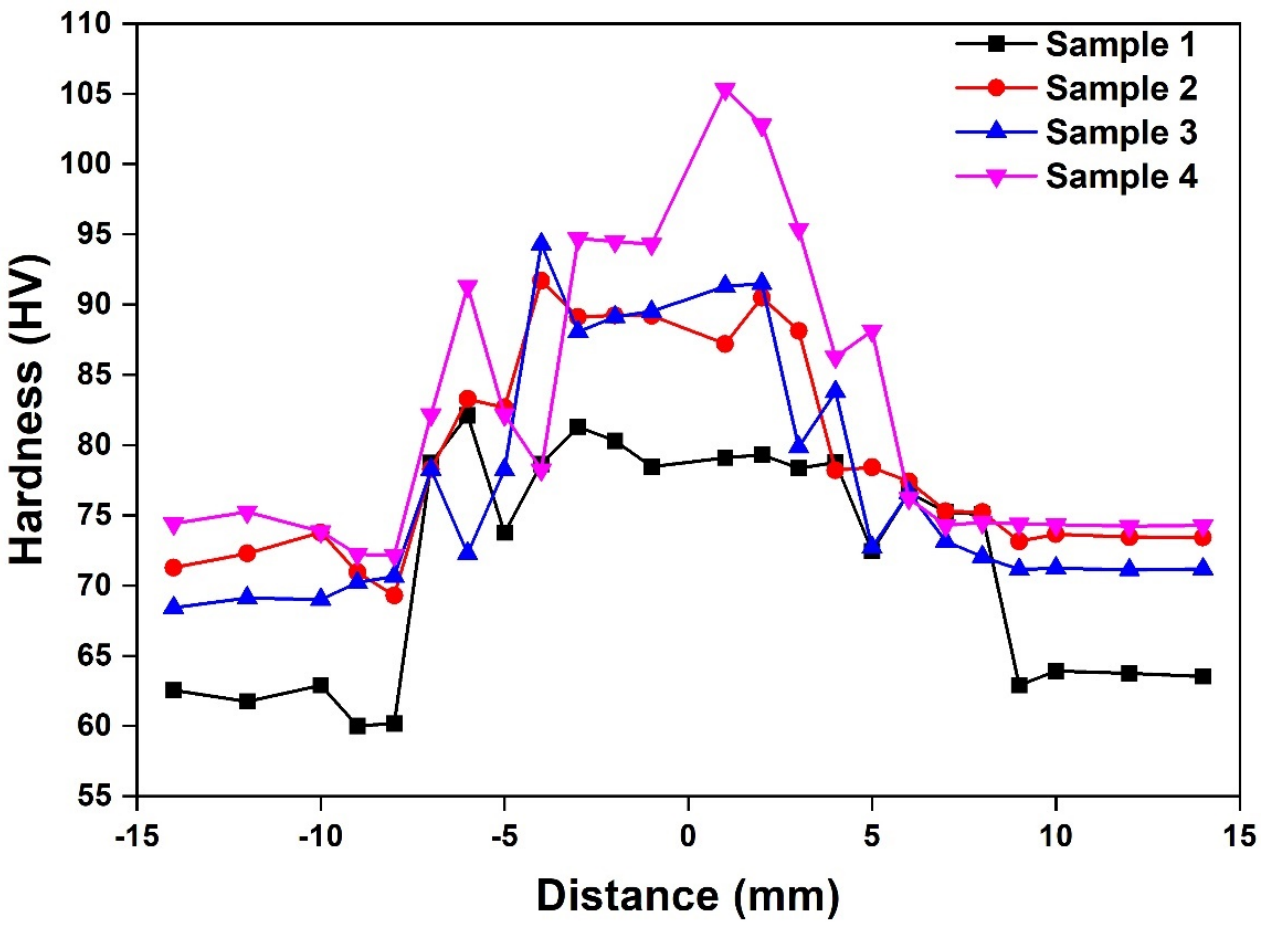
Figure 6. Comparison of hardness for friction stir welded Al-MMCs samples.